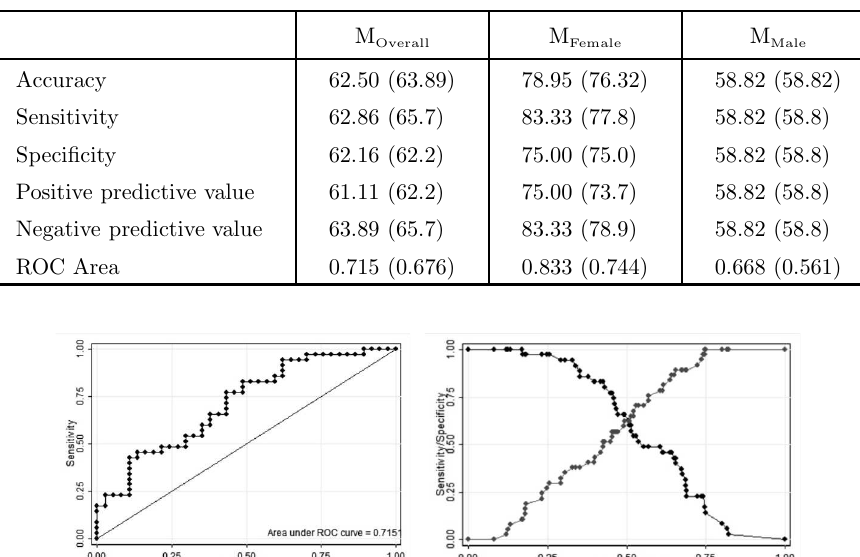
Table 12. Detailed classification characteristics